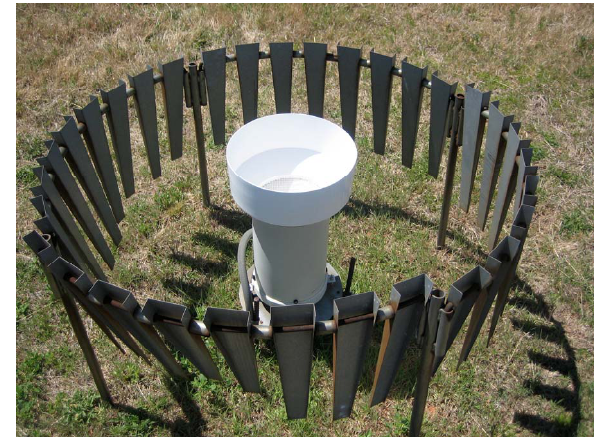
Fig. 3. Close-up of the TN gauge at the Norman Mesonet site with Fig. 3 Close-up of the TN gauge at the Norman Mesonet site with surrounding wind shield. surrounding wind shield.